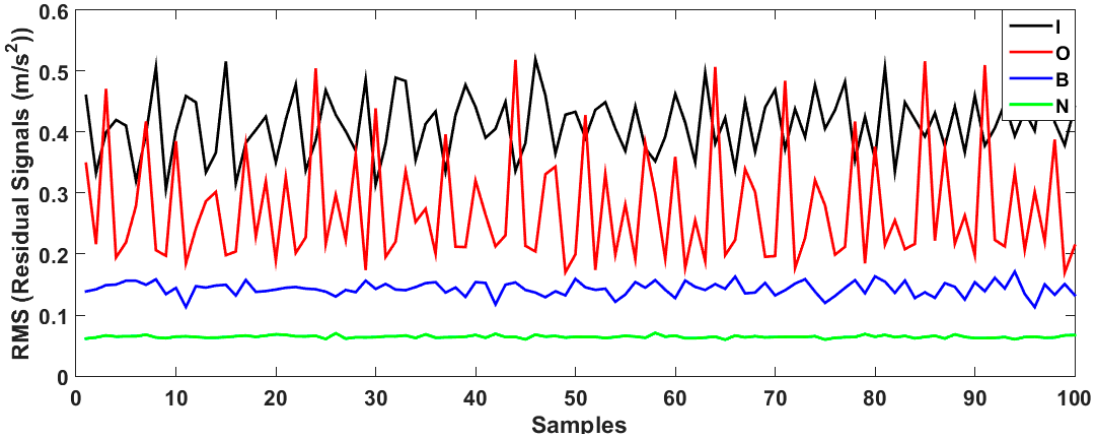
Figure 10. Bearing’s RMS residual signals using the FVS method.